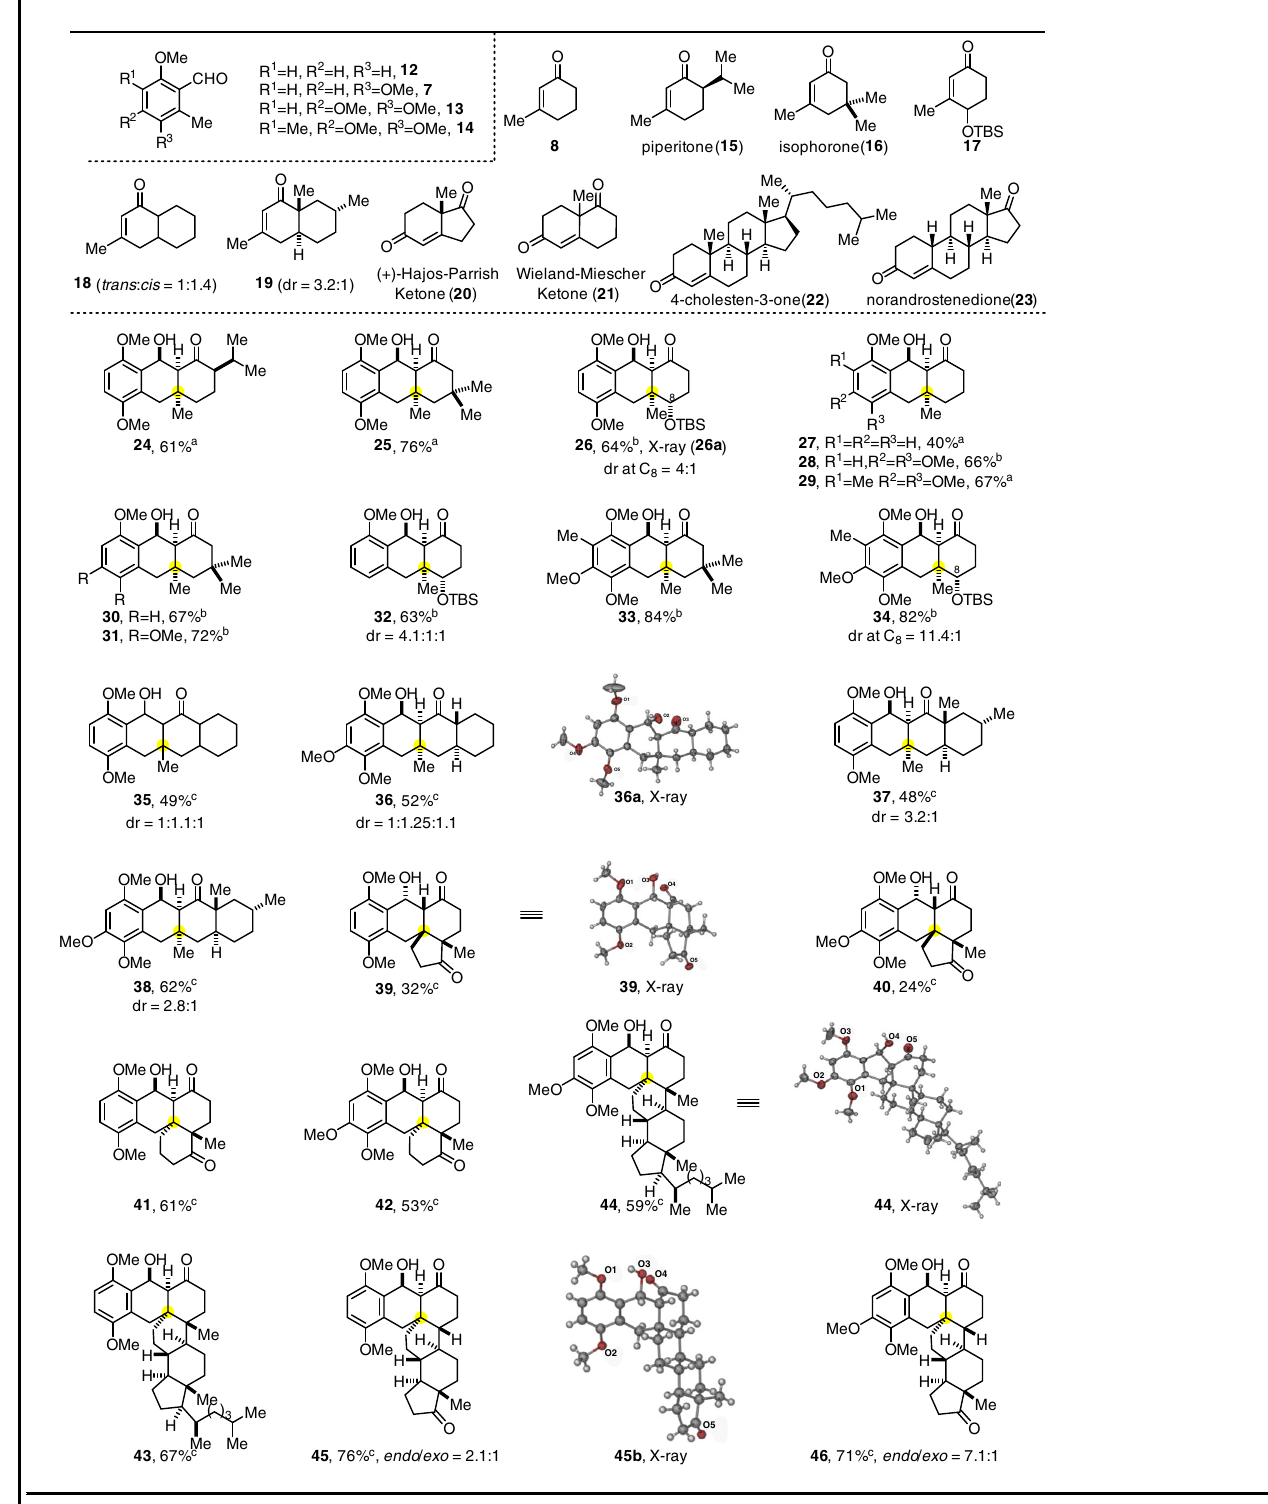
Table 2 Scope of the PEDA reaction involving β -substituted cyclohexenones as dienophiles